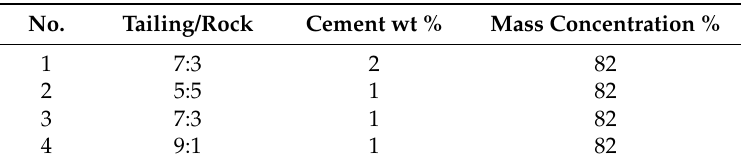
Table 2. The component of